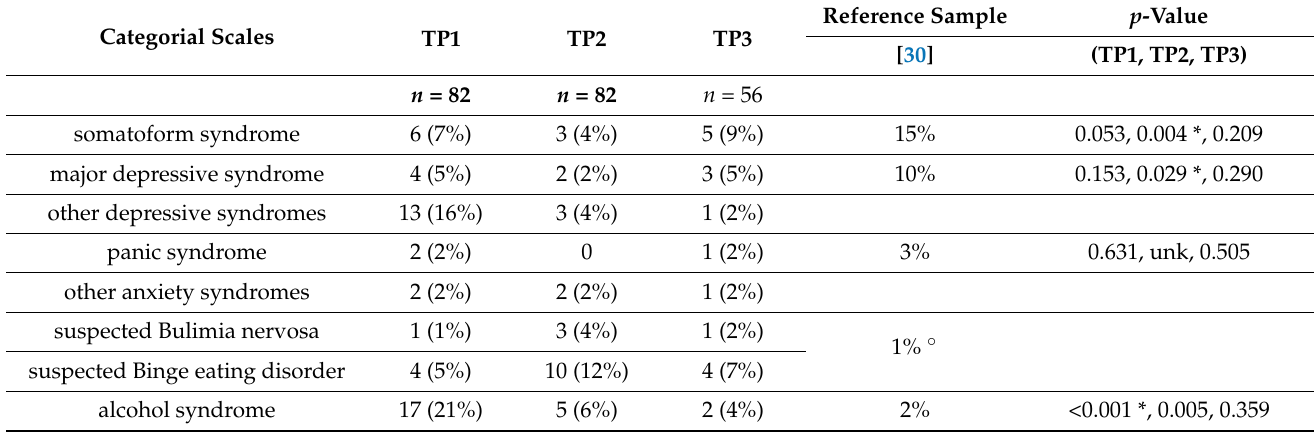
Table 7. Frequency and rates of the categorial scales and Chi-square test for equal distribution for the comparison of the categorial scales with the reference sample by Jacobi et al.